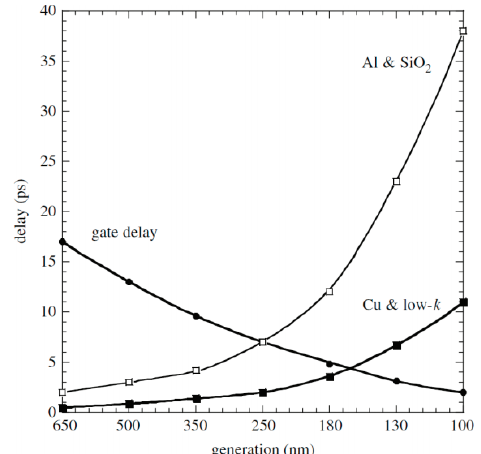
Figure 1. Gate and interconnect delay in accordance with technology generations (ITRS ’99) [6].